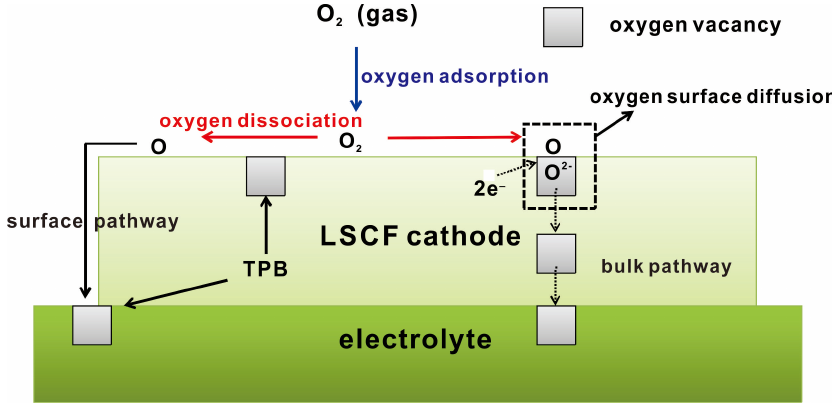
Figure 2. Schematic illustration of the two possible oxygen incorporation paths in La 0.6 Sr 0.4 Co 0.2 Fe 0.8 O 3 −δ (LSCF)